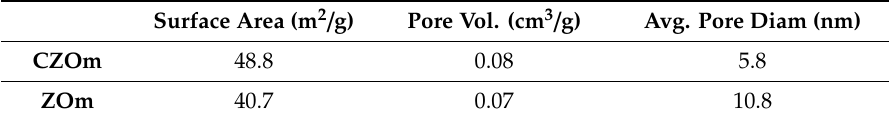
Table 1. Surface area, pore volume, and average pore diameter of the CZOm and ZOm. Surface Area (m 2 /g)